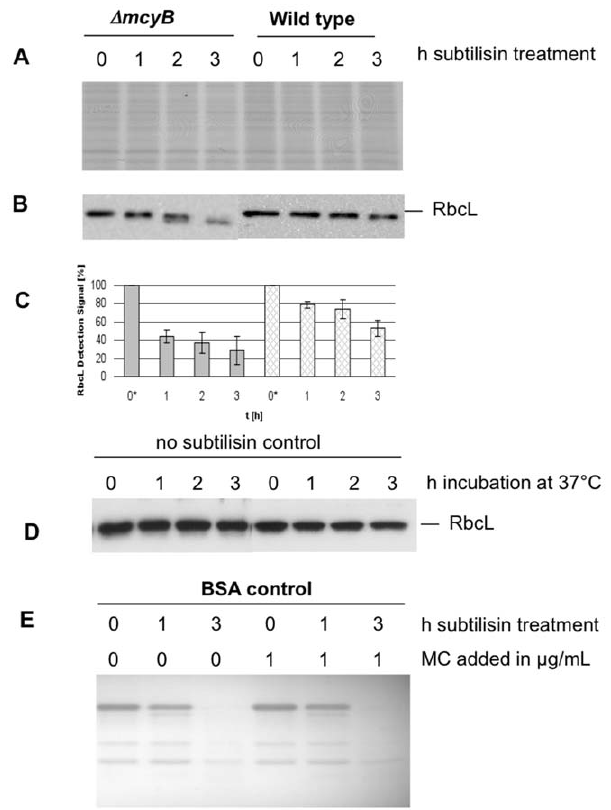
Figure 6. Protein degradation assay. A) Coomassie gel picture showing M. aeruginosa PCC7806 wild type and D mcyB cell extracts treated for up to 3 hours with 0.2 m g/mL subtilisin. B) Immunoblot analysis using a specific RbcL antibody. C) Quantification of RbcL signal intensity from three independent subtilisin assays for M. aeruginosa PCC7806 wild type and D mcyB mutant. * The starting points were adjusted to 100% D) Control treatment without addition of subtilisin for three hours. E) Control digestion of BSA with subtilisin in presence or absence of microcystin.